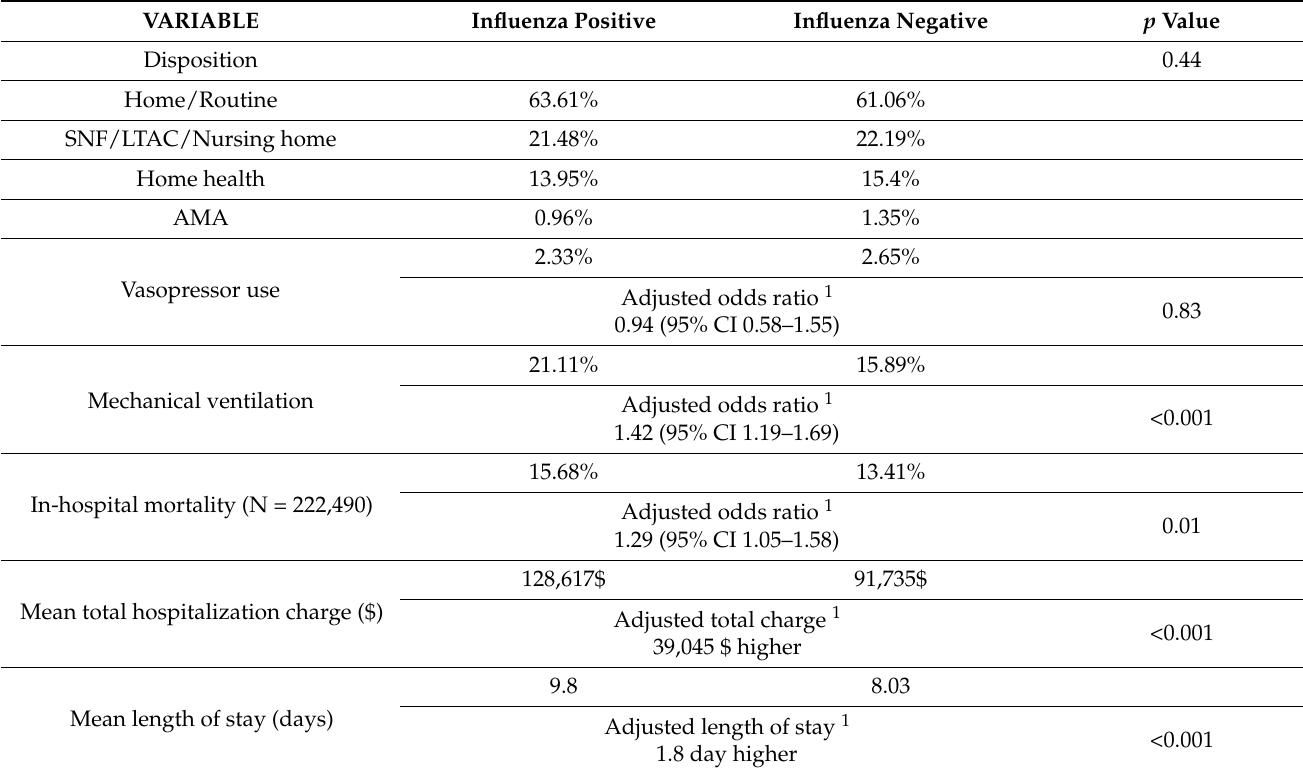
Table 2. In-hospital outcomes. SNF = skilled nursing facility, LTAC = Long-term acute care, AMA = against medical